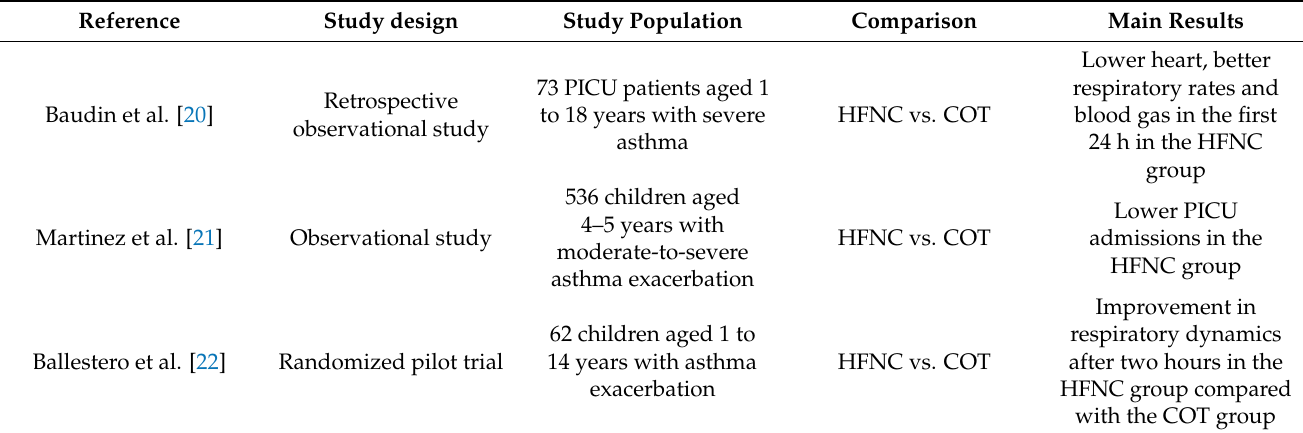
Table 2. Use of HFNC in children with